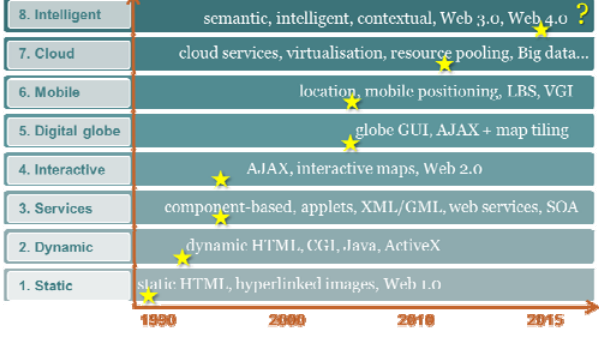
Figure 1: Web mapping developments supporting web map use (Source: Veenendaal, 2015)